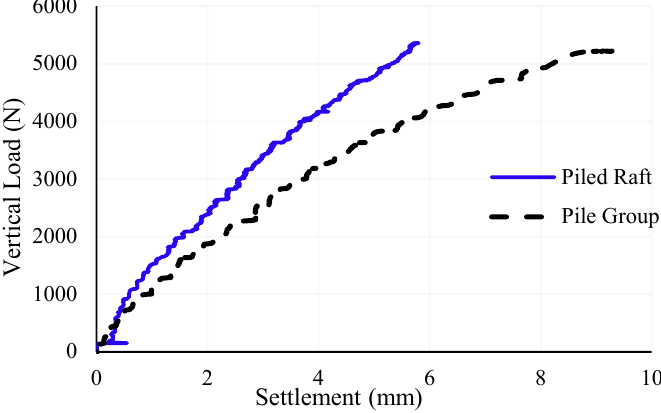
Figure 17. 13-pile group vs. 13-piled raft vertical response.